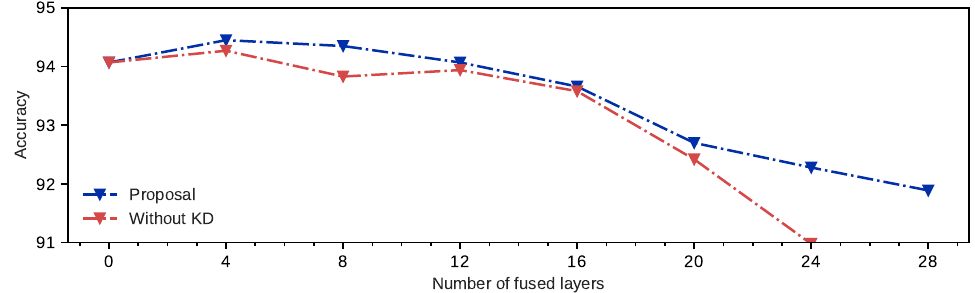
Figure 4. Details of the layer-fusion experiment on DenseNet-40 without knowledge distillation.